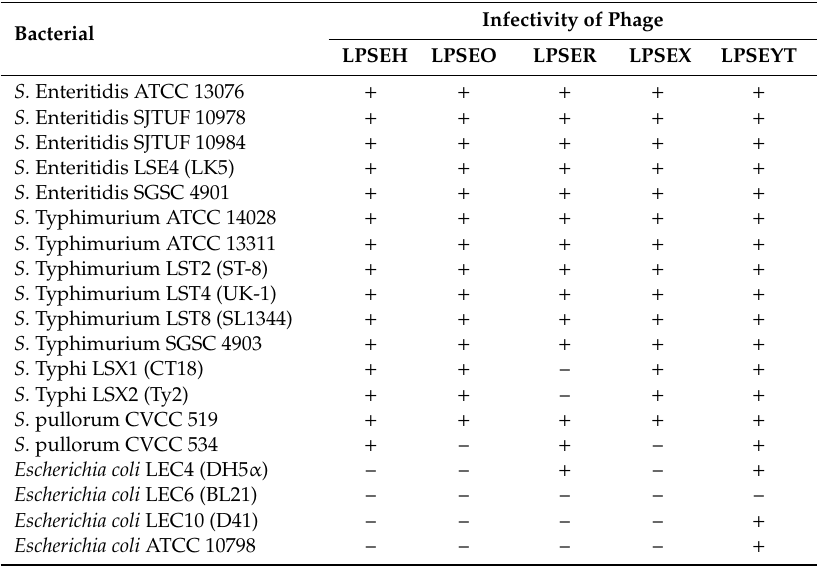
Table 1. Lytic range of phages LPSEH, LPSEO, LPSER, LPSEX, and LPSEYT.